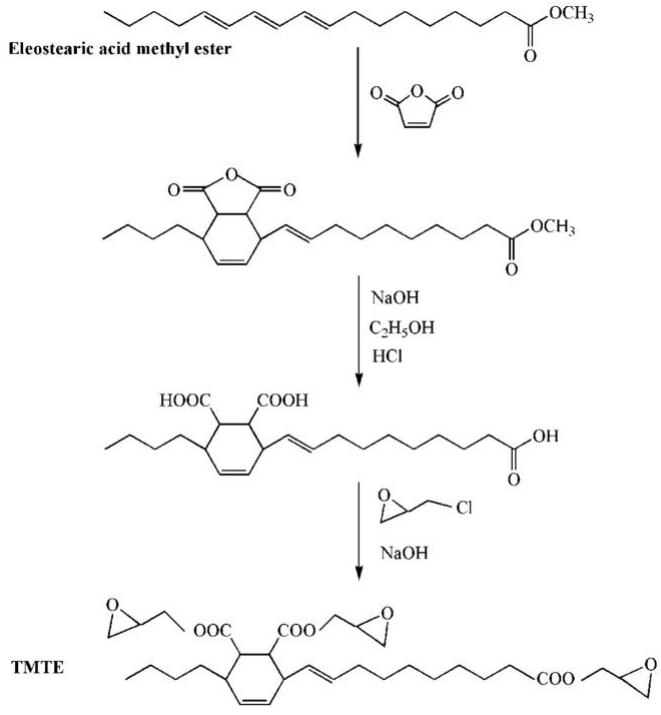
Figure 4. Synthesis of tung-maleic triglycidyl esters (TMTE).